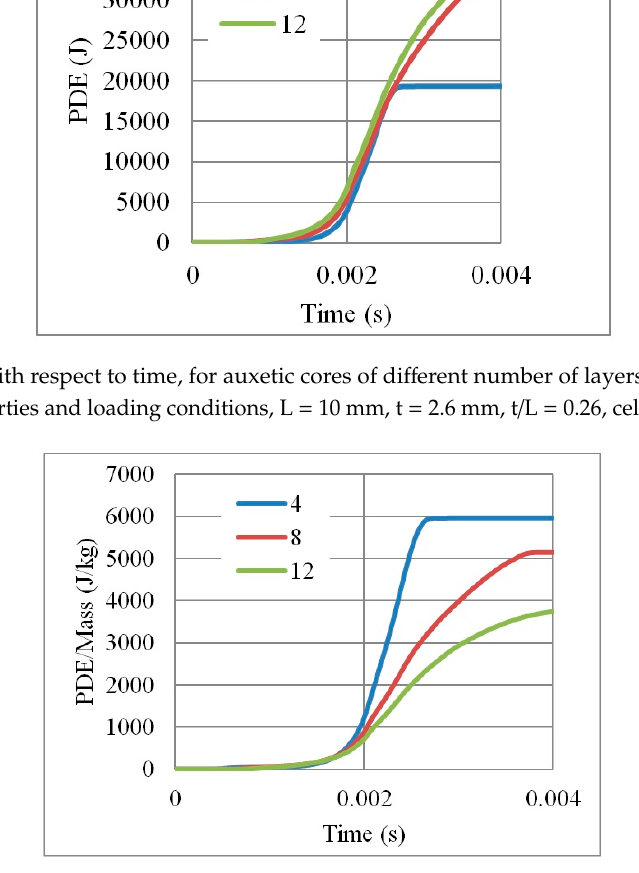
Figure 19. PDE/Mass with respect to time, for auxetic cores of different number of layers, having the same geometrical properties and loading conditions, L = 10 mm, t = 2.6 mm, t/L = 0.26, cell angle = 60°, AL3.